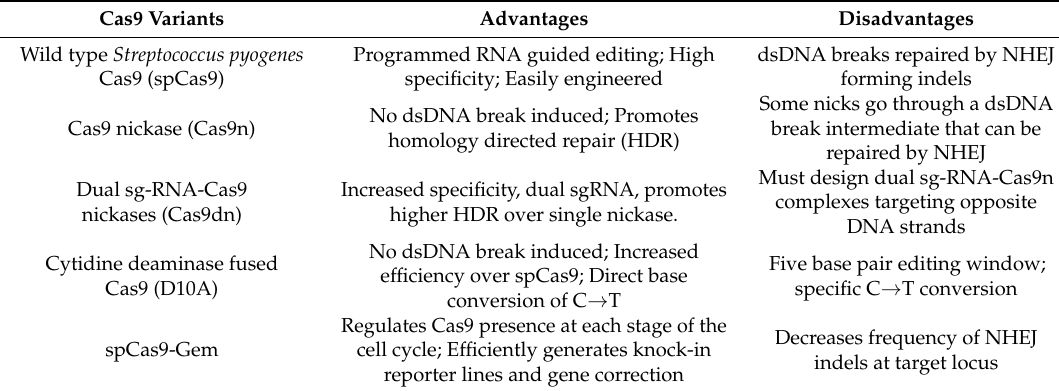
Table 1. Summary of engineered Cas9 variants for gene editing